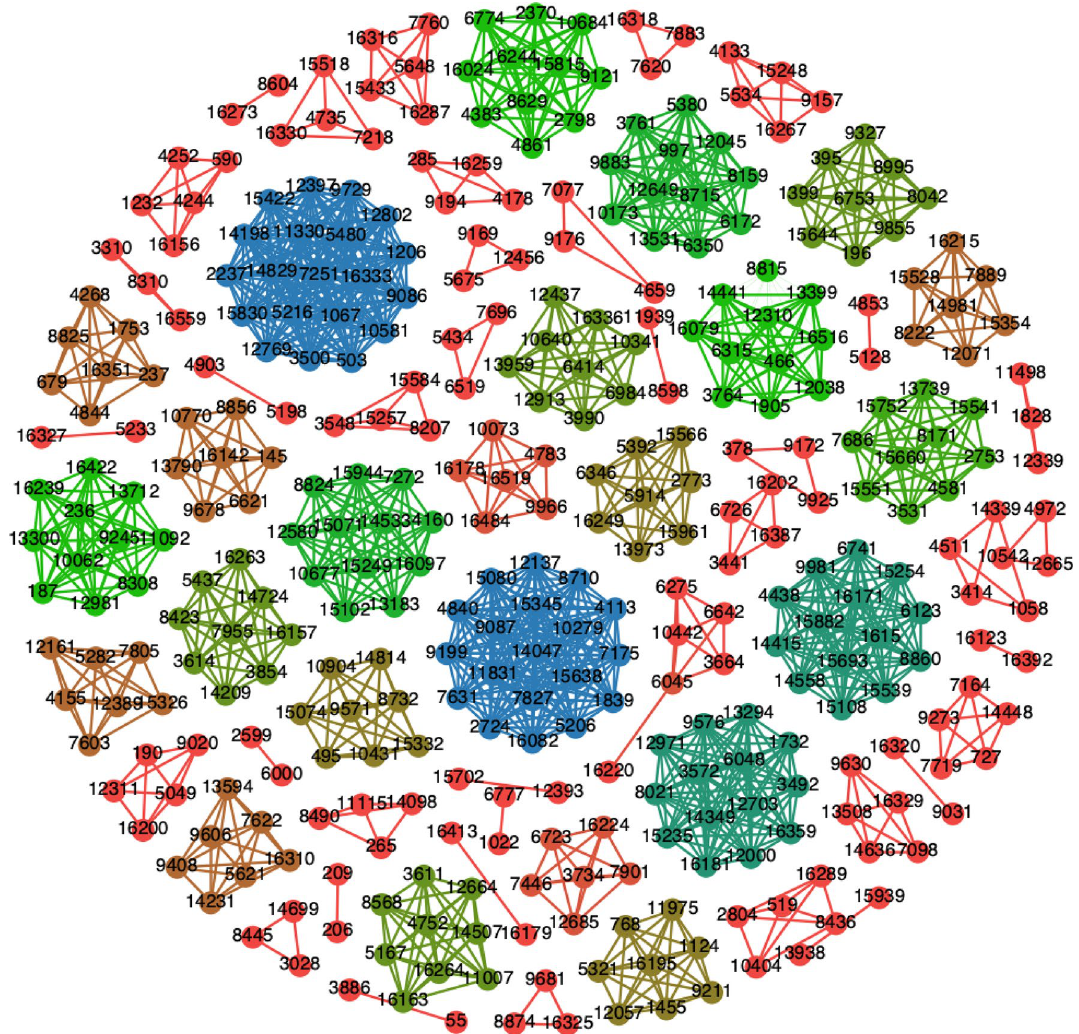
Figure 9. Co-occurrence network for Tibetan population (> 4000 m) with co-occurrence frequency equal to 1. The colour is representing the degree of nodes. Blue for higher degree while green for intermediate degree and red for lower degree nodes. The figure was created using Gephi version 0.9.1 (https ://gephi .org/) 60